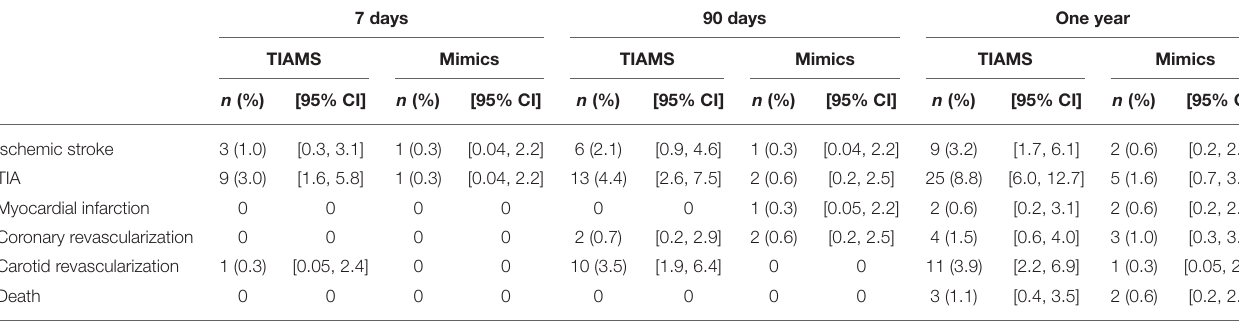
Carotid revascularization